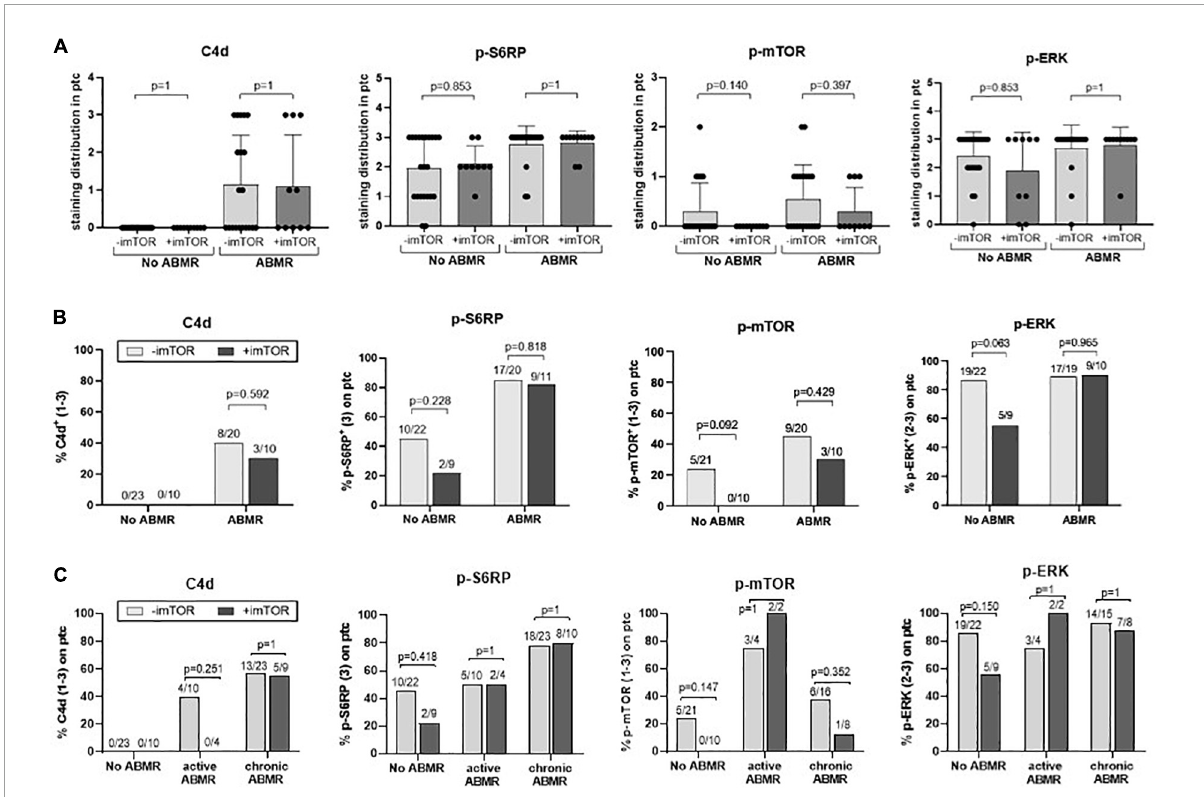
FIGURE4 Potential modulation of C4d, p-S6RP, p-mTOR, and p-ERK staining by mTORi immunosuppression. Staining score (A) and percentage of positive staining (B) of C4d, p-S6RP, p-ERK, and p-mTOR in PTC of renal allografts biopsies with ABMR + DSA+ treated ( n = 11) or not ( n = 20) with mTORi, and ABMR–DSA– treated ( n = 4) or not ( n = 7) with mTORi. Plots of staining score show the means (bars), standard deviation (error bars), and individual values (dots) for each sample. Kruskal-Wallis test was used to assess significant differences among groups for staining score and Fisher exact test for proportions of staining. (C) Percentage of positive staining for C4d, p-S6RP, p-ERK, and p-mTOR in PTC of renal allografts biopsies with active and chronic ABMR, compared to no ABMR, receiving or not mTORi immunosuppression. Fisher exact test was used to assess significant differences among